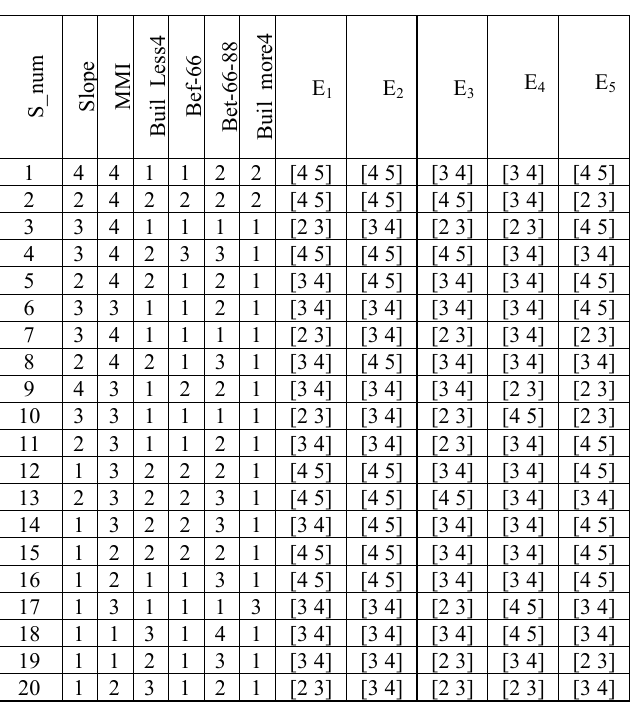
Table1. Information table for 20 randomly selected Tehran statistical units